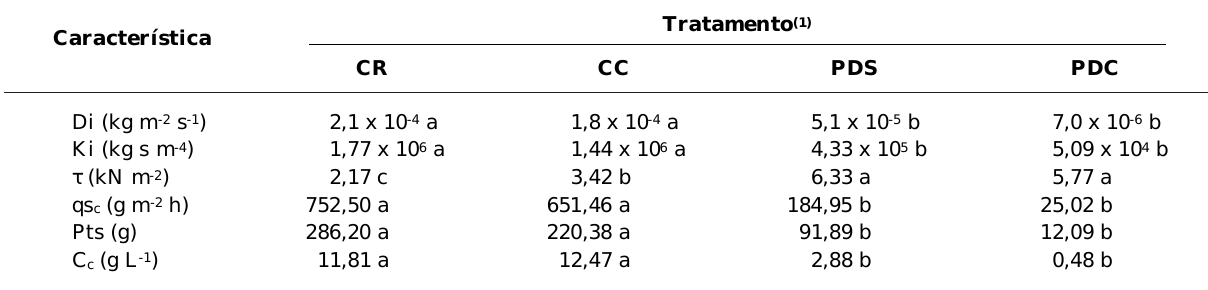
Quadro 4. Taxa máxima de desagregação (Di), erodibilidade em entressulcos (Ki), resistência do solo ao cisalhamento ( ttttt ), taxa constante de erosão de solo (qs ), perda total de solo (Pts) e concentração c constante de sedimento (C ), considerando diferentes preparos e consolidação do c